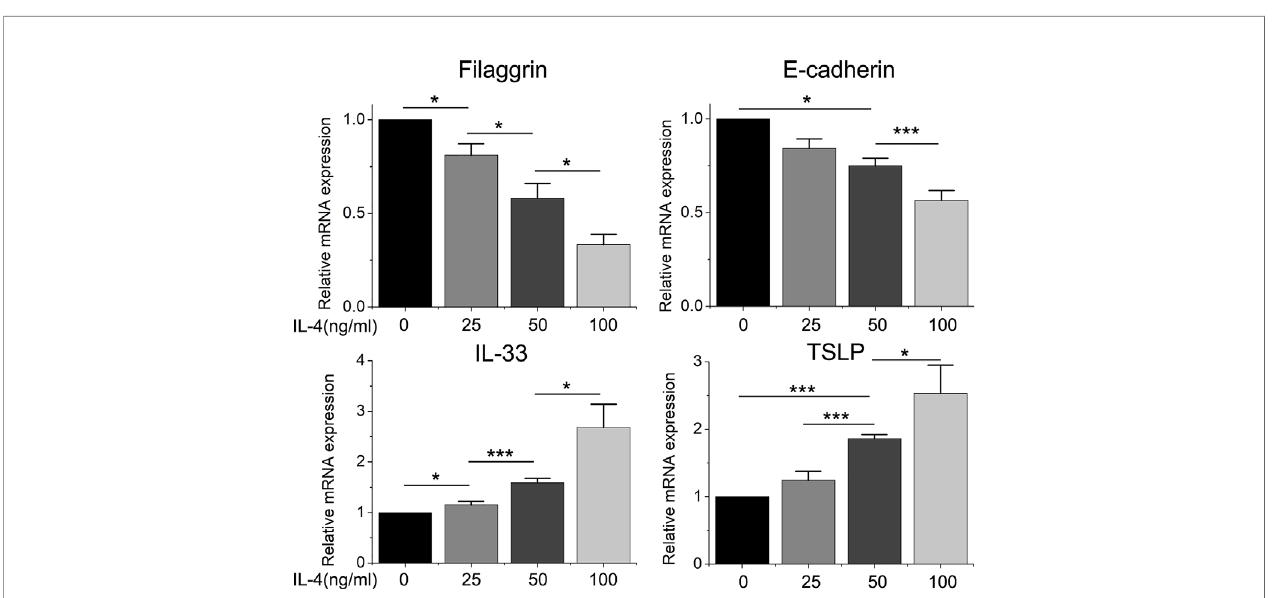
FIGURE 5 | The mRNA expression of fi laggrin, E-cadherin, IL-33 and TSLP in BEAS-2B cells treated with different concentration of IL-4. Quantitative data are presented as the mean ± standard deviation (n=3). The Student ’ s t-test was used to analyze the difference between groups. *P < 0.05 was considered as statistically signi fi cant. ***P <